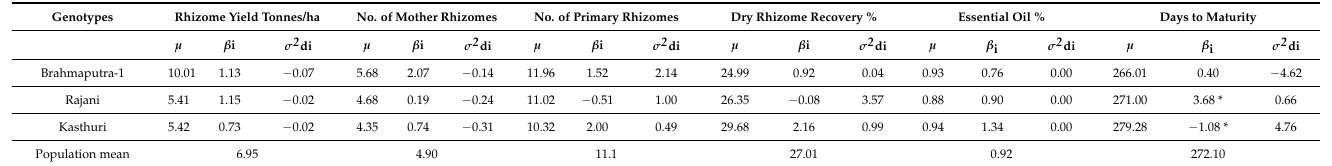
Table 5. Stability analysis performed using the Eberhart and Russell model of agro-morphological and quality traits of “Bharamputra-1” and the control